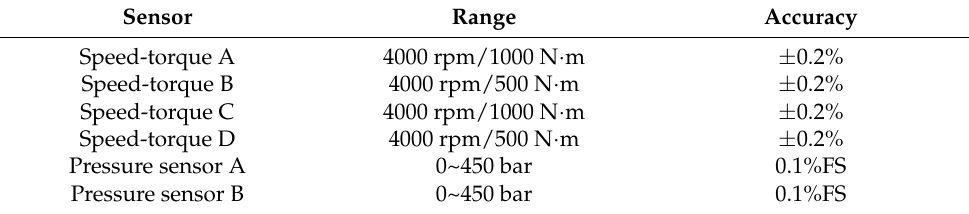
Table 1. The technical